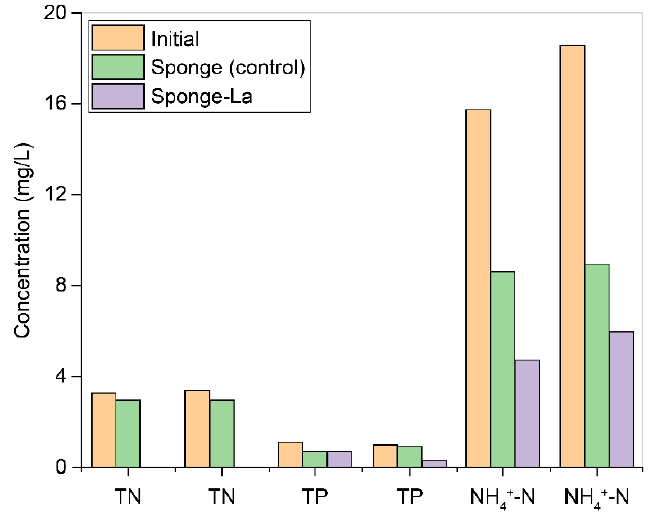
Figure 5. Effect of pH on the matrix of agar – La when the initial concentration of PO 43 − was 10 mg/L ( a ); effect of pH on adsorption by agar – La after 40 h ( b ).